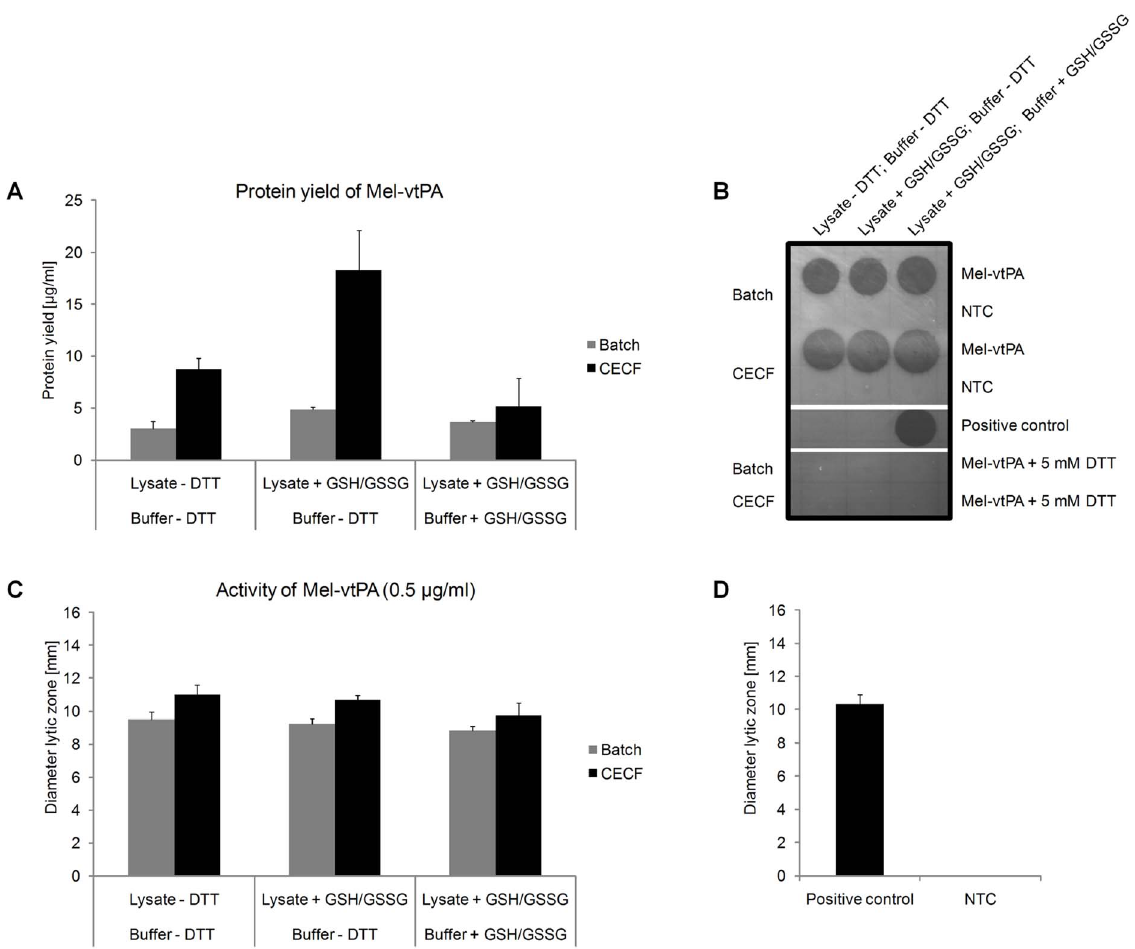
Figure 6. Analysis of Mel-vtPA expression and activity. Cell-free reactions were performed for 48 h in batch and CECF mode in absence of DTT, but in presence of caspase inhibitor and 14 C-leucine using three differently composed reaction mixtures. (i) lysate without GSH and GSSG; (ii) lysate supplemented with GSH and GSSG and (iii) buffer and lysate supplemented with GSH and GSSG. A) Diagram showing total yields of 14 C-leucine labeled Mel-vtPA. B) Fibrin-agarose-plate showing lytic zones created by biologically active Mel-vtPA. All samples were diluted to 0.5 m g/ml. Activity of Mel-vtPA is completely abolished after addition of 5 mM DTT. C) Activity of Mel-vtPA analyzed by fibrin-agarose-plate assay. D) Activity of the positive control (= purified full length tPA, 0.5 m g/ml, Anaspec) analyzed by fibrin-agarose-plate assay. NTC = No template control; translation reaction without addition of a DNA template. Standard deviations were calculated from triplicate analysis (n=3).